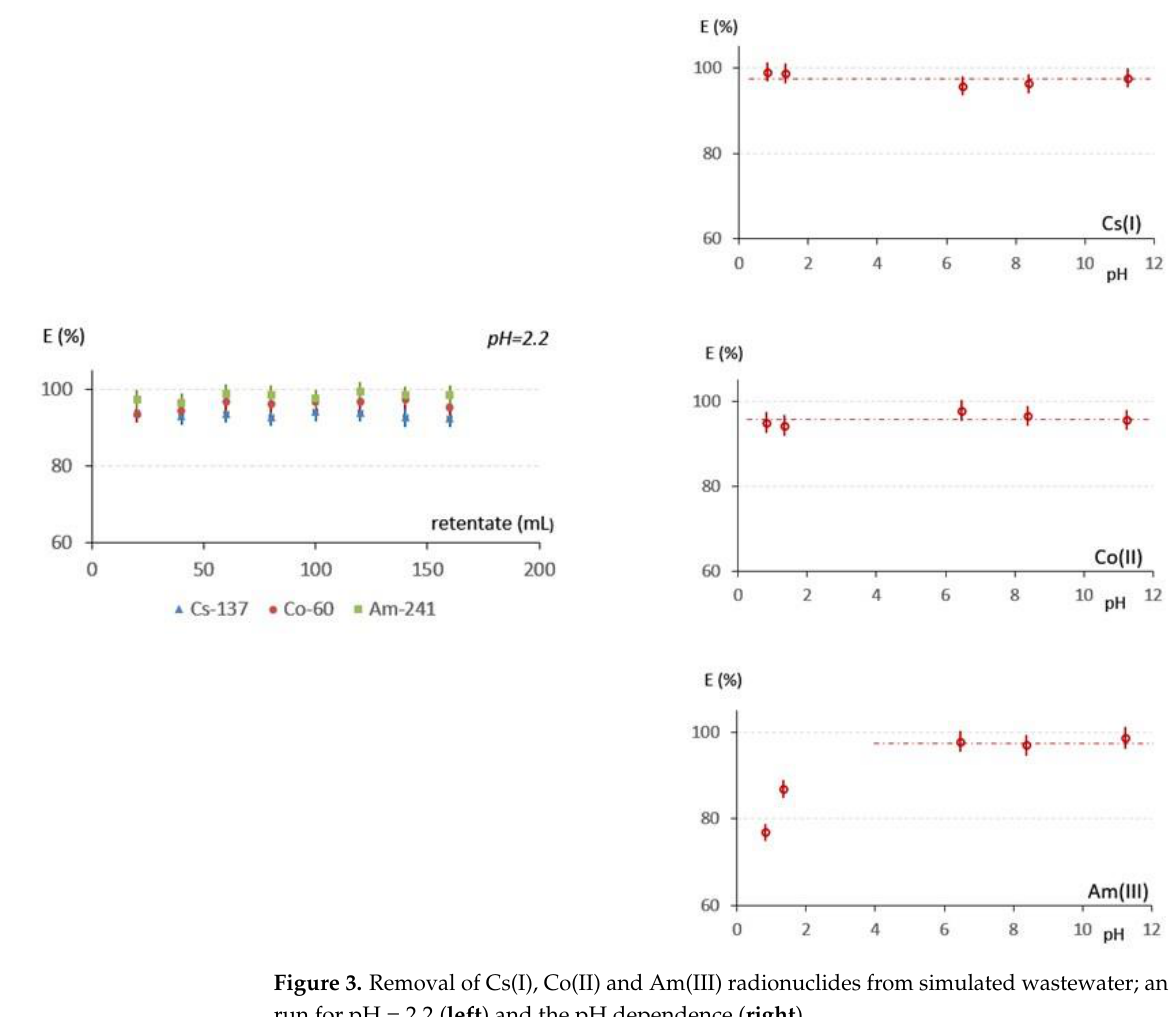
Figure 4. Dependence of the purification efficiency, E (%), of three radioactive metal cations on the CSS dose (g · L −1 ).